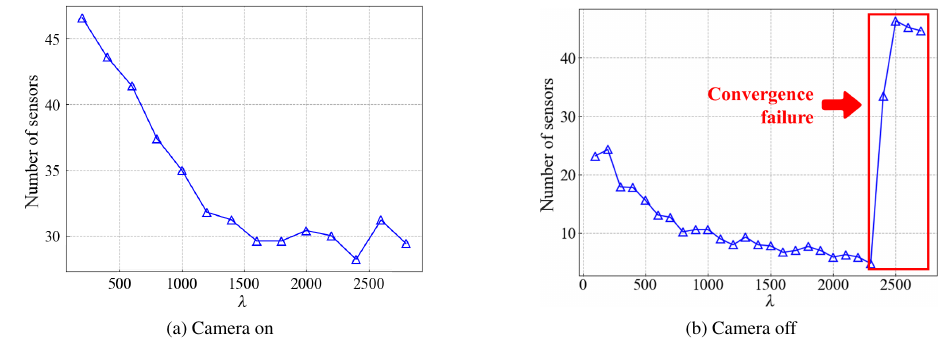
Fig. 8 Influence of (cid:21)(cid:21)(cid:21) on the number of sensors.